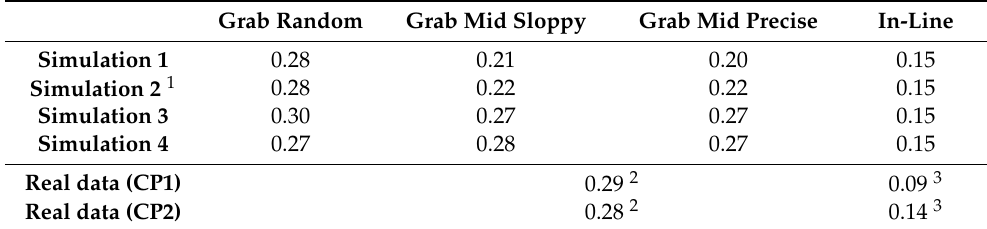
Table 2. Variation in estimated batch means for different sampling regimes. The true variation is 0.15 for all simulated data sets. Grab Random